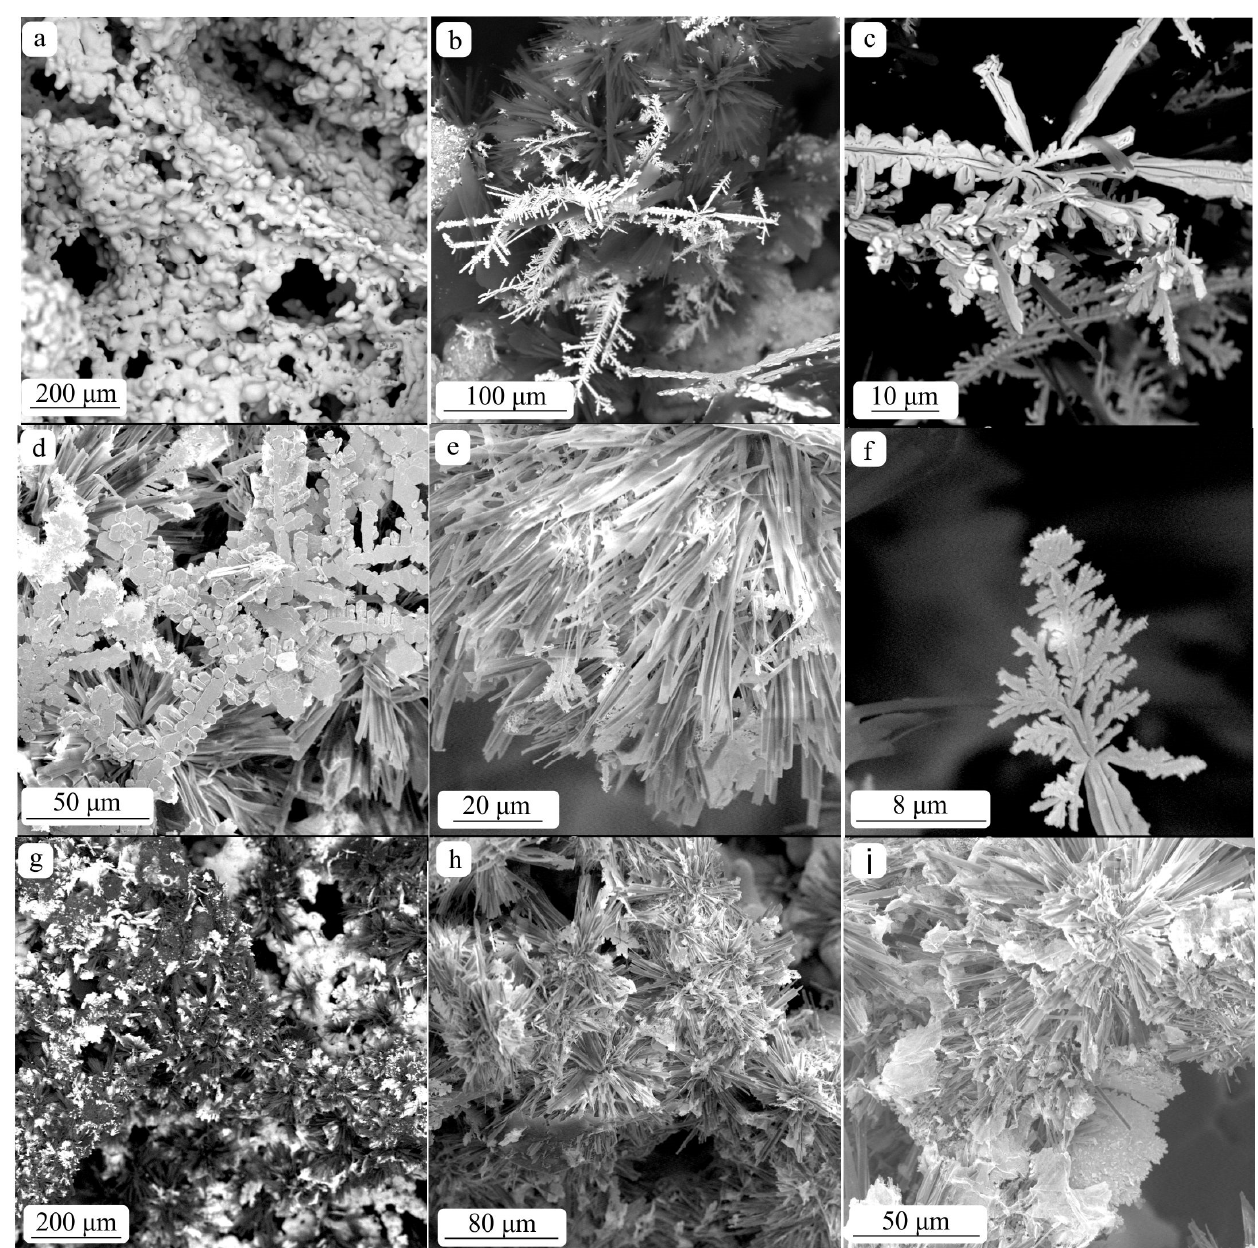
Figure 5. ( a ) Copper substrate. SEM images of hydrophobic films grown at: 20 min immersion time in silver nitrate solution and ( b , c ) 40 min in stearic acid solution, ( d – f ) 50 min in stearic acid solution, ( g – i ) 60 min in stearic acid solution.